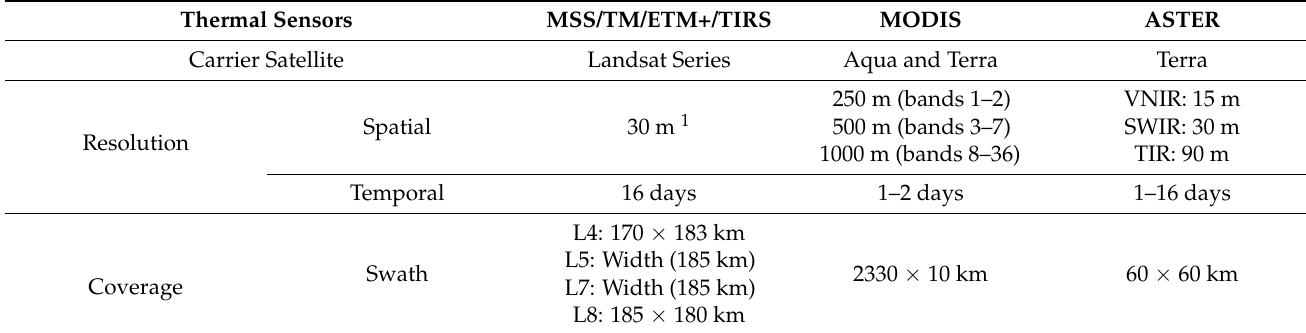
Table A1. Characteristics of the satellite data sources used in SUHI